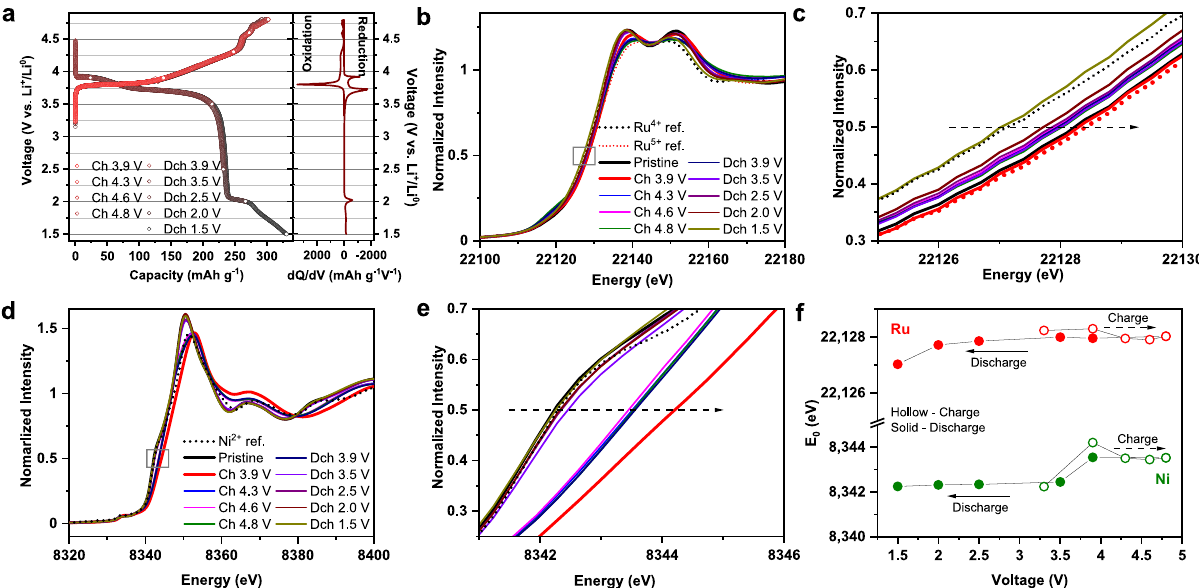
Fig. 4 Cationic redox mechanism of Li 1.2 Ni 0.4 Ru 0.4 O 2 . a Voltage pro fi les and dQ/dV plot of Li 1.2 Ni 0.4 Ru 0.4 O 2 , showing samples (open circles) for ex situ XAS analysis. b , c XANES of Ru K -edge. d , e XANES of Ni K -edge. f Ni and Ru K-edge energy measured at half maxima at different states of